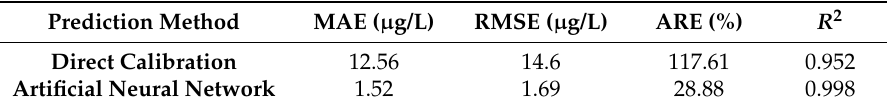
Table 4. The statistical parameters of the direct calibration model and BP-ANN model.